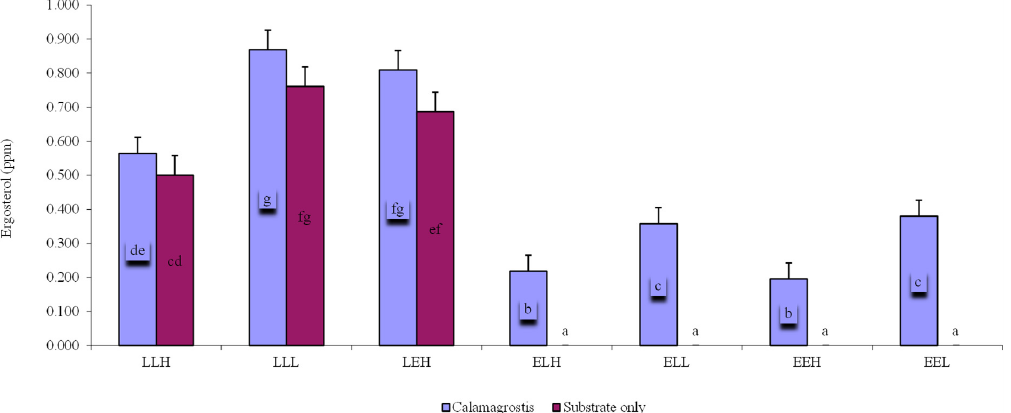
Figure 6. Average ergosterol content (ppm) for individual treatments with the addition of litter Calamagrostis epigejos (Calamagrostis) or without the addition of litter (Substrate only). Error bars are standard deviation. Results are based on one-way ANOVA. If ANOVA was significant for soil type, the results of the post hoc test are given (Fischer LSD, p < 0.05). Homogeneous statistical groups are indicated by the same letters. The analysis of correlation coefficients between the parameters of individual soils showed that microbial respiration in the whole microcosm correlated with microbial